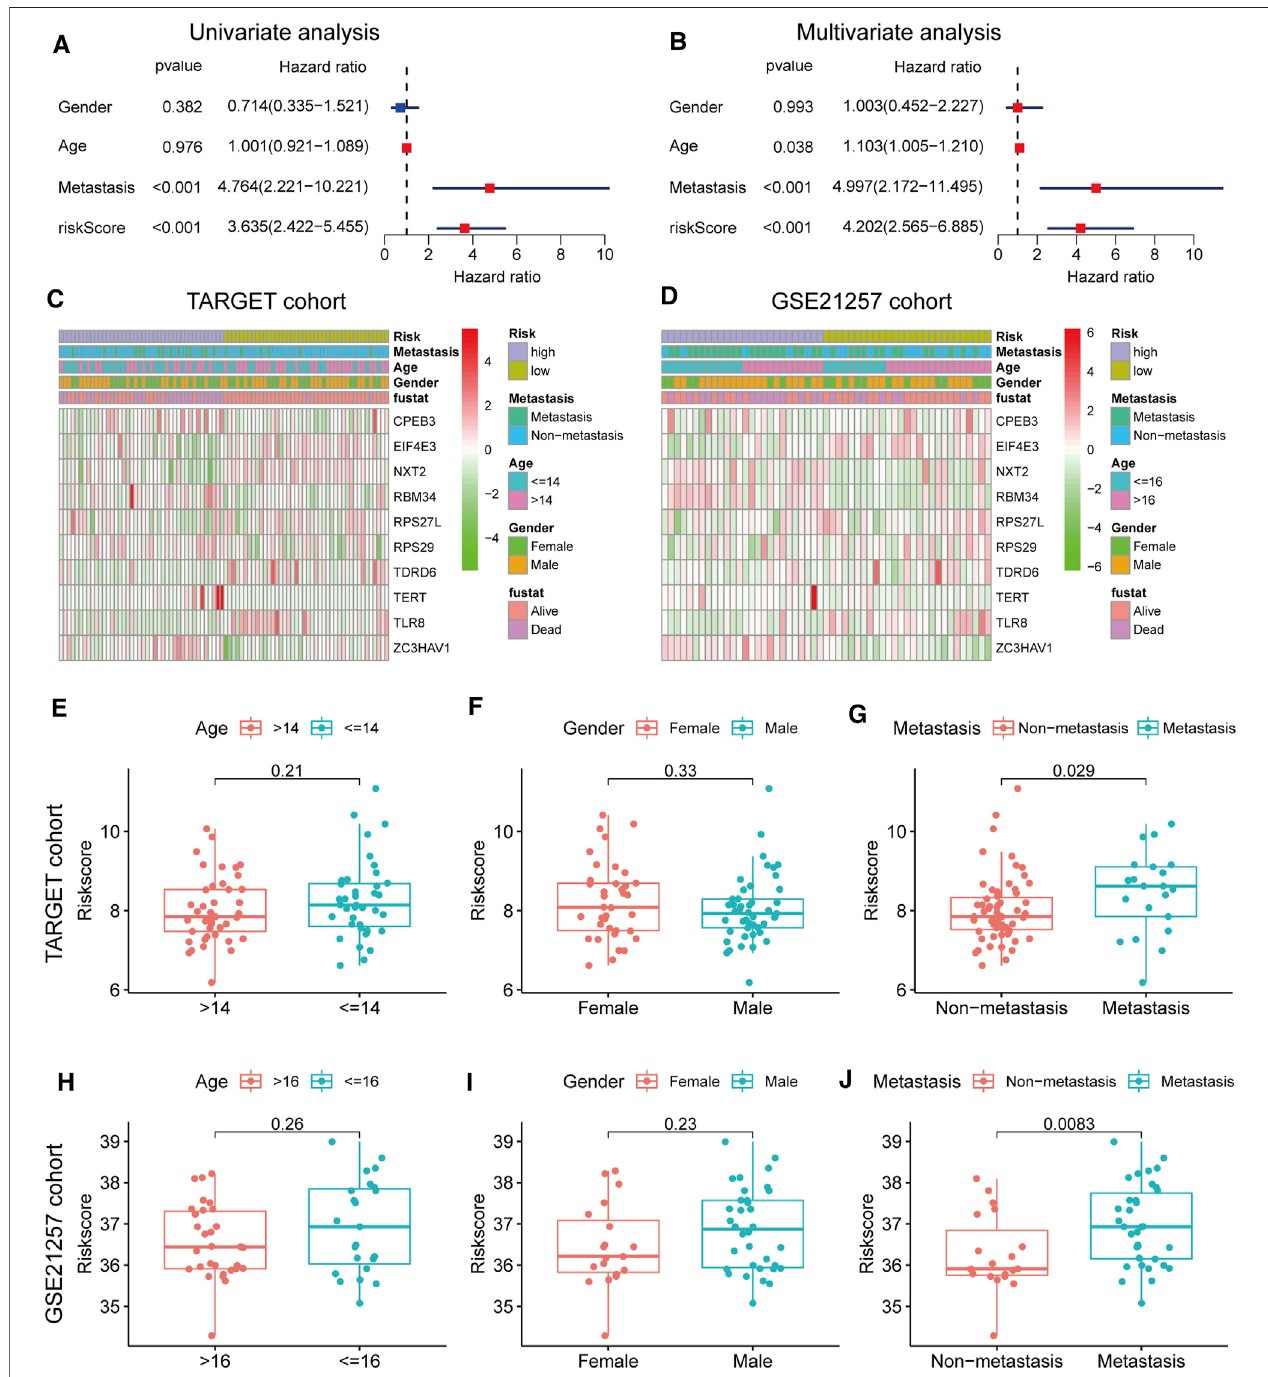
FIGURE 4 | Clinical correlation analyses (A,B) Univariate and multivariate cox analysis showed the RBP genes signature and metastasis were two independent predictors of prognosis in osteosarcoma (C,D) The heatmap of the expression pattern of RBP is associated with the RBP signature and other clinical features (E – G) Relationship between risk score and clinical pathological factor in the TARGET cohort (H – J) Relationship between risk score and clinical pathological factor in the GSE21257